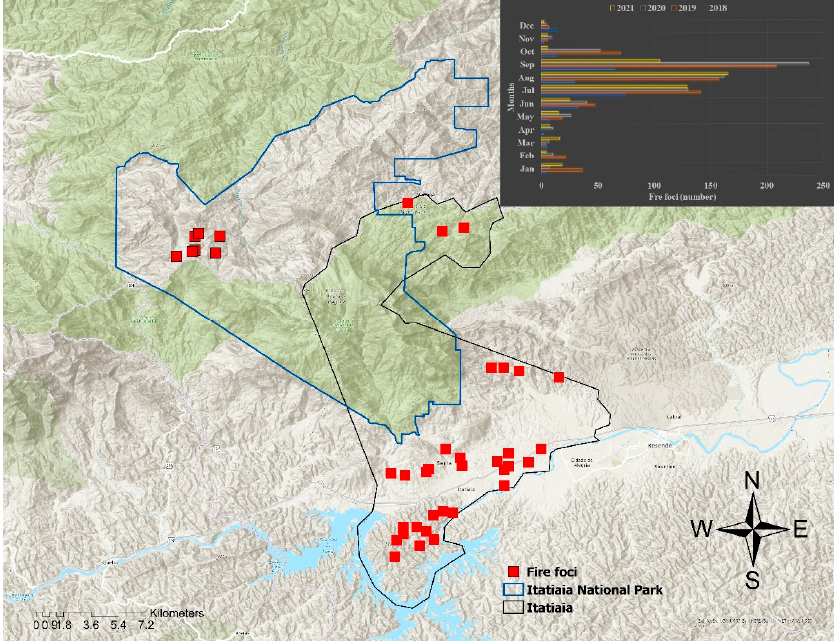
Figure 2. Distribution of fire foci points and monthly variation during the years 2018–2021 that served for the correlation analysis between the FIAF model and fire foci in Itatiaia National Park, Brazil.